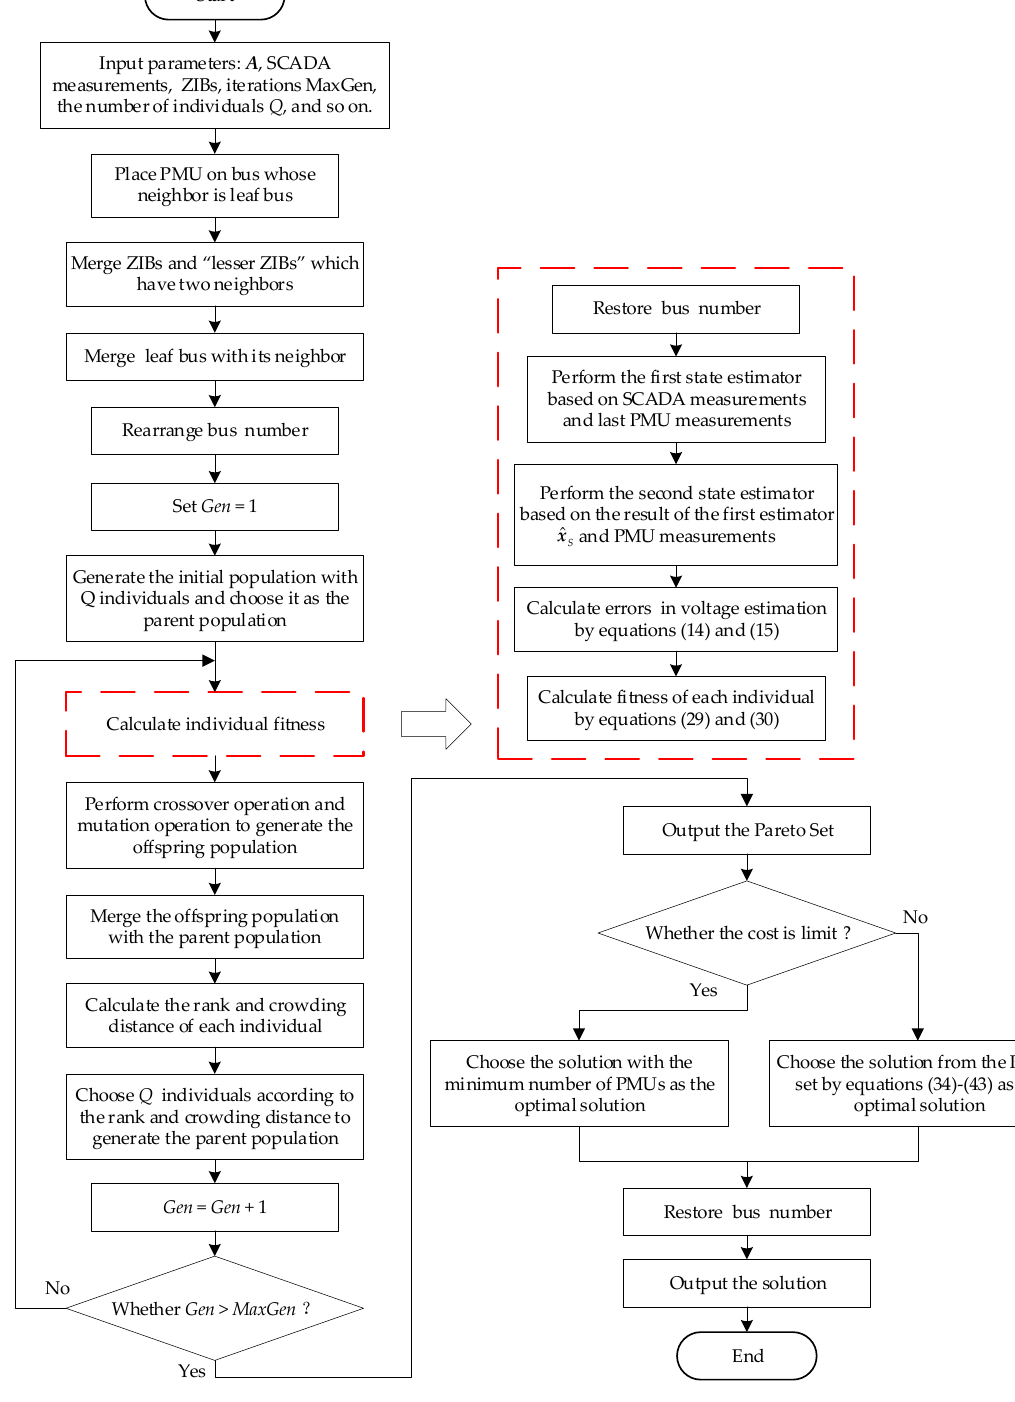
Figure 1. The flow chart of the proposed optimal phasor measurement unit (PMU) placement (OPP) method in the compressed distribution network considering cost and state estimation accuracy.